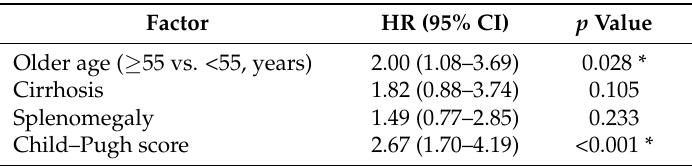
Table 3. Multivariate analysis for prognostic factors of overall survival